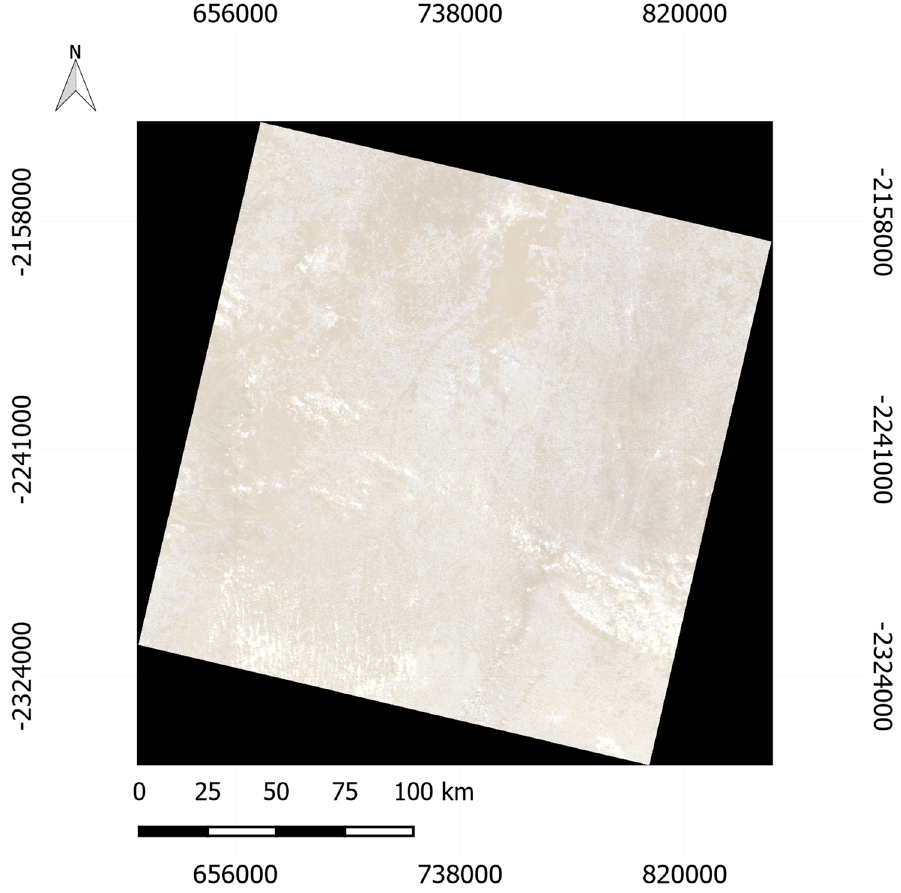
Figure 3. Example of a Landsat 8 scene related to the Doce River basin in Brazil presented as a band composition R(4)G(3)B(2). The Doce River and its tributaries are not visible because this image was not zoomed. In the coordinate grid, the UTM false northing (10,000 km) was not added to the N coordinate.